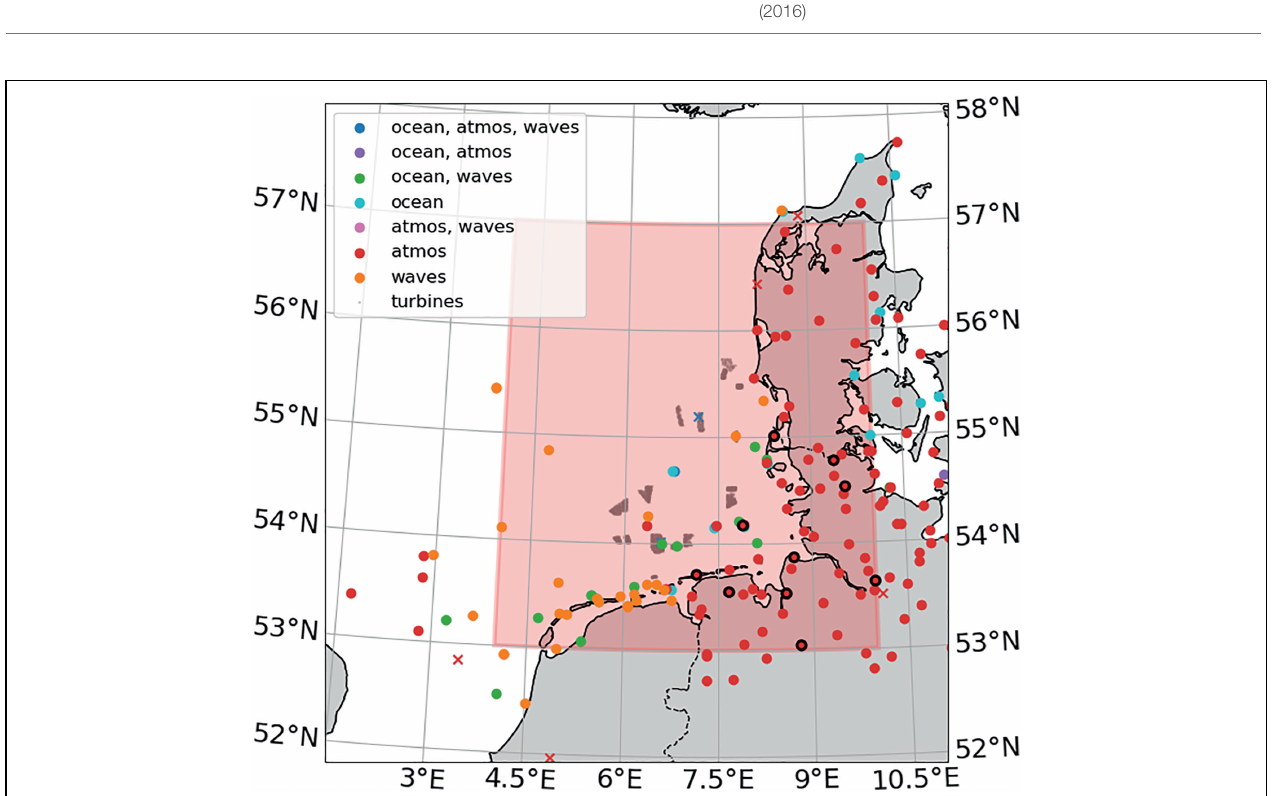
FIGURE 2 | Measurements around the German Bight colour-coded based on the observation type. Crosses indicate tall masts. The red area represents the focus area around the existing wind turbines in 2020 (gray dots). Circles with black edges indicate base sample stations.